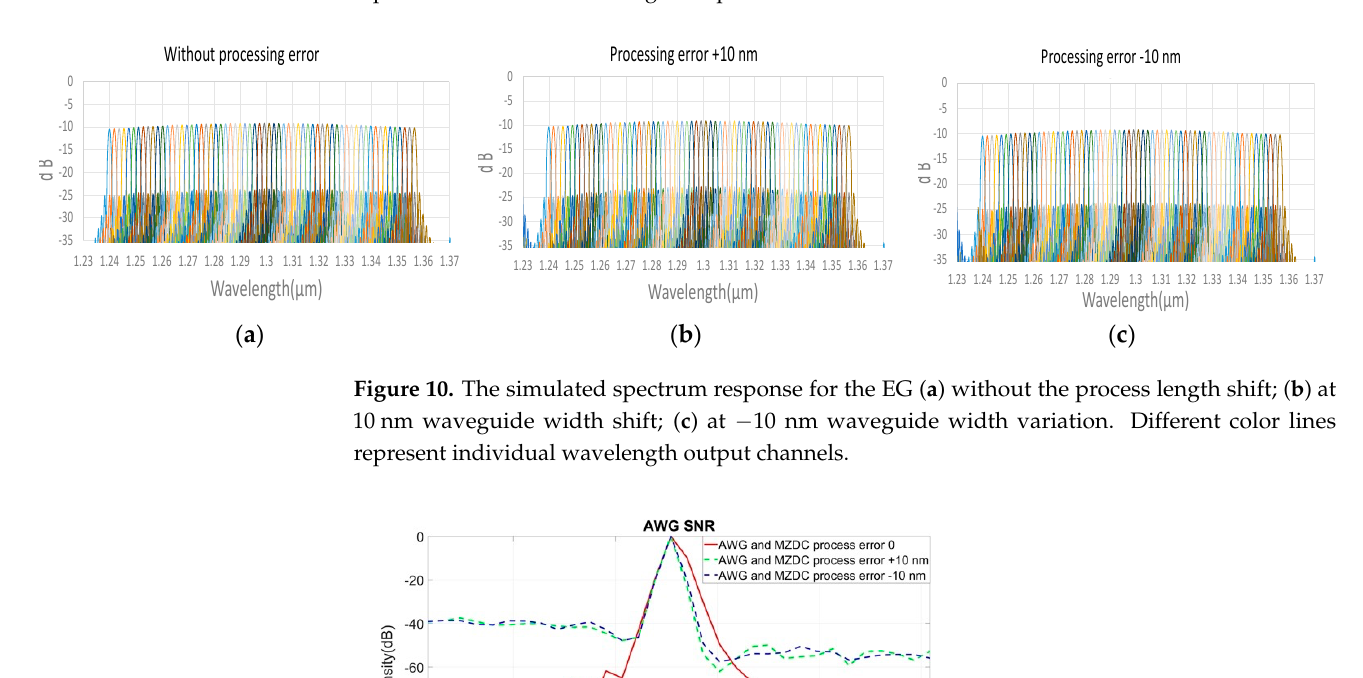
Figure 12. PSF from the MZDC interrogated with EG. Relative position (mm)